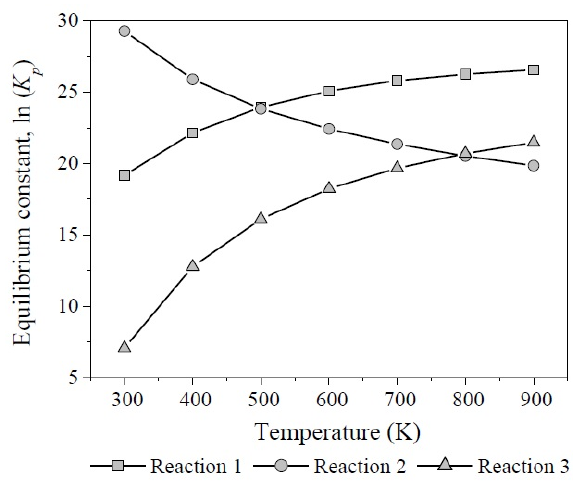
Figure 12. Equilibrium constants as function of temperature for the reactions 1, 2, and 3 involved in glycerol dehydration.